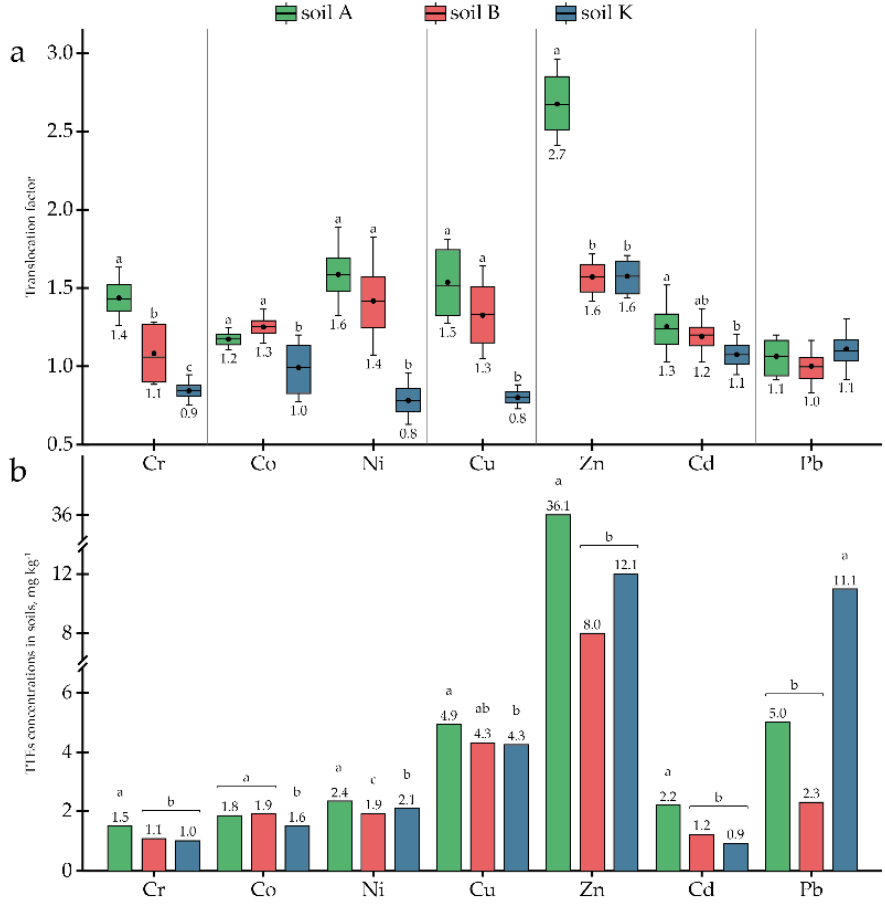
Figure 4. Translocation factors for TTEs: ( a ) TLFs; ( b ) concentrations in soil. Different letters on the bar and boxplots within one element indicate a significant difference at p < 0.05.